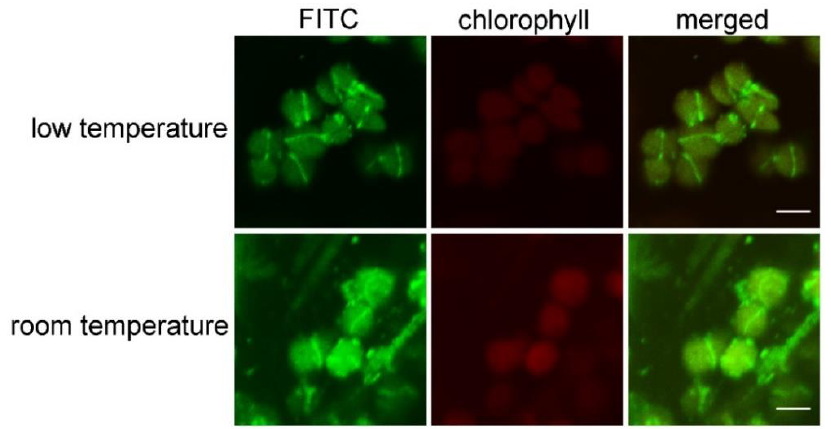
Figure 3. A comparison of the fluorescence signal between samples prepared at low temperature (0 – 4 °C) and samples prepared at room temperature. Images from two samples were captured with the same exposure condition. Bars = 5 μm.